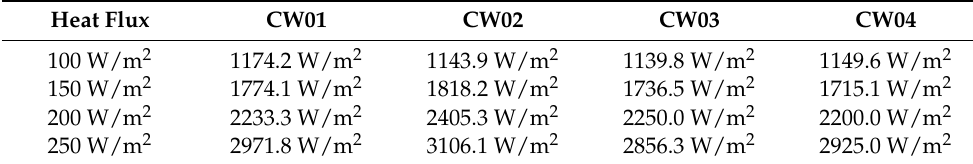
Table 5. Heat flux through the wall.